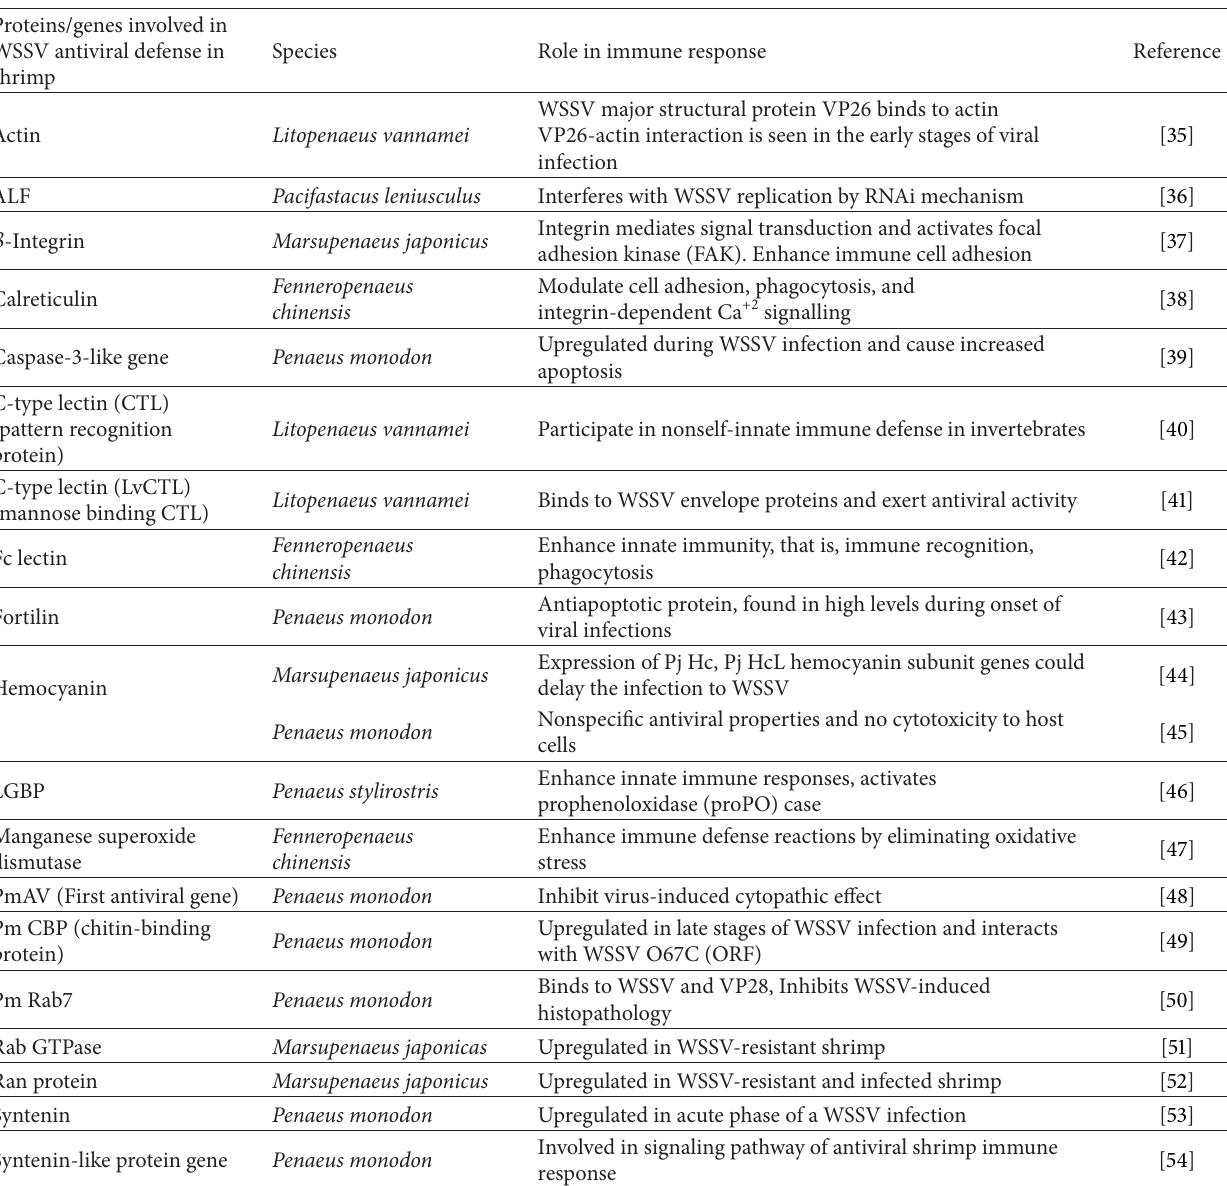
Table 4: Proteins/genes involved in WSSV antiviral defense in